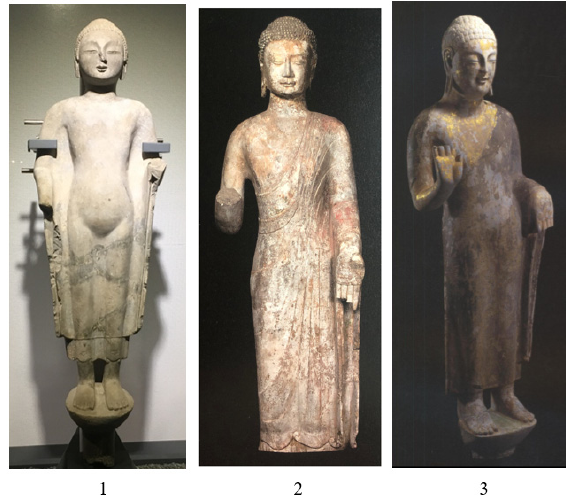
Figure 1. The main types of Qingzhou-style carved-in-the-round standing Buddha statues. (1): Bud- dha with diaphanous robe draped over both shoulders (type A), mid-6th century, excavated from Zhucheng, Shandong Province, Zhucheng Museum (source: photograph by the author). (2): Buddha with densely pleated robe covering only the left shoulder (type B), mid-6th century, excavated from the Longxing Temple site, Qingzhou, Shandong Province (source: Fan 2016, p. 95). (3): Buddha with diaphanous robe covering only the left shoulder (type C), mid-6th century, excavated from the Longxing Temple site (source: The National Museum of Chinese History 1999, p. 110).